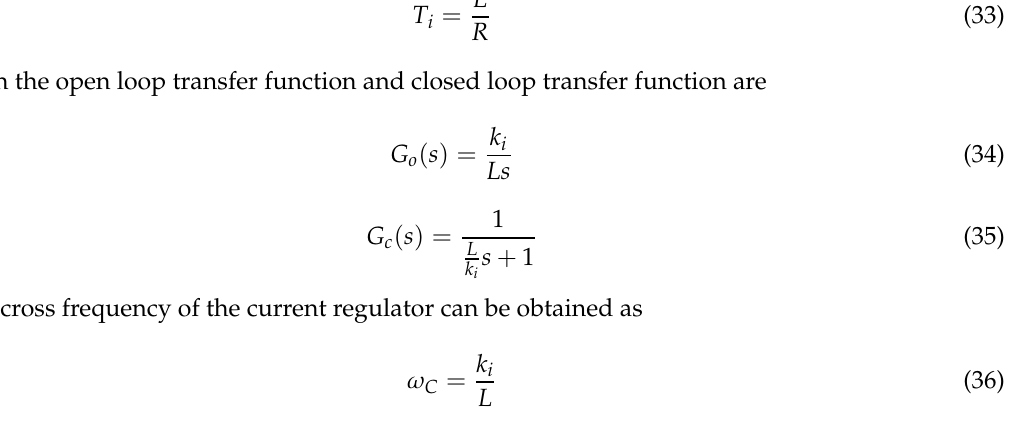
Figure 12. Transfer function block of the current regulator.